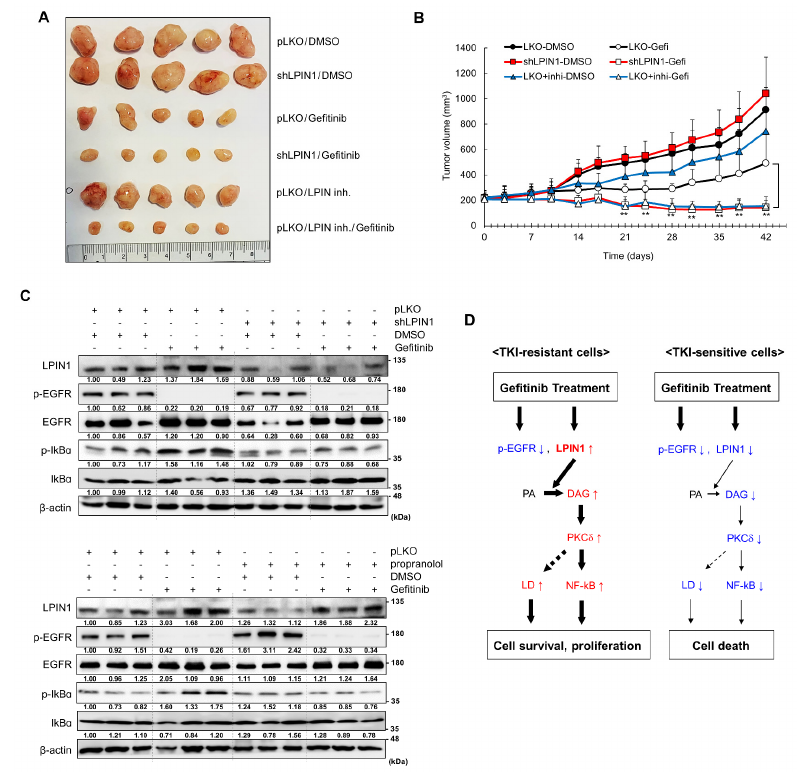
Figure 6. Loss of LPIN1 expression sensitizes EGFR-mutant NSCLC cells to gefitinib in vivo. ( A , B ) Mice bearing H1650/shLPIN1 or H1650/pLKO tumor xenografts were subcutaneously injected with 30 mg/kg gefitinib or/and 10 mg/kg LPIN inhibitor, propranolol or vehicle twice a week ( n = 5/group), and tumor growth was monitored for 6 weeks. ( A ) Tumors resected from each group at the end of experiments and profiles of tumor growth during 6 weeks of gefitinib treatment. ( B ) For